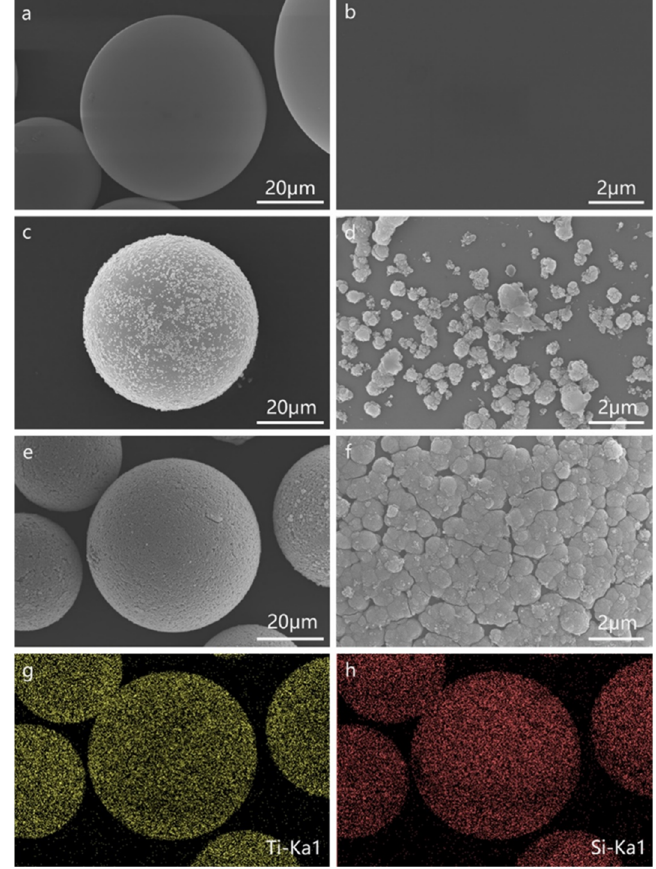
Figure 3. SEM images of ( a , b ) pristine HGM; ( c , d ) HGM-R; ( e , f ) HGM-RC; ( g ) Ti and ( h ) Si elements’ distribution on HGM-RC microspheres’ surfaces.